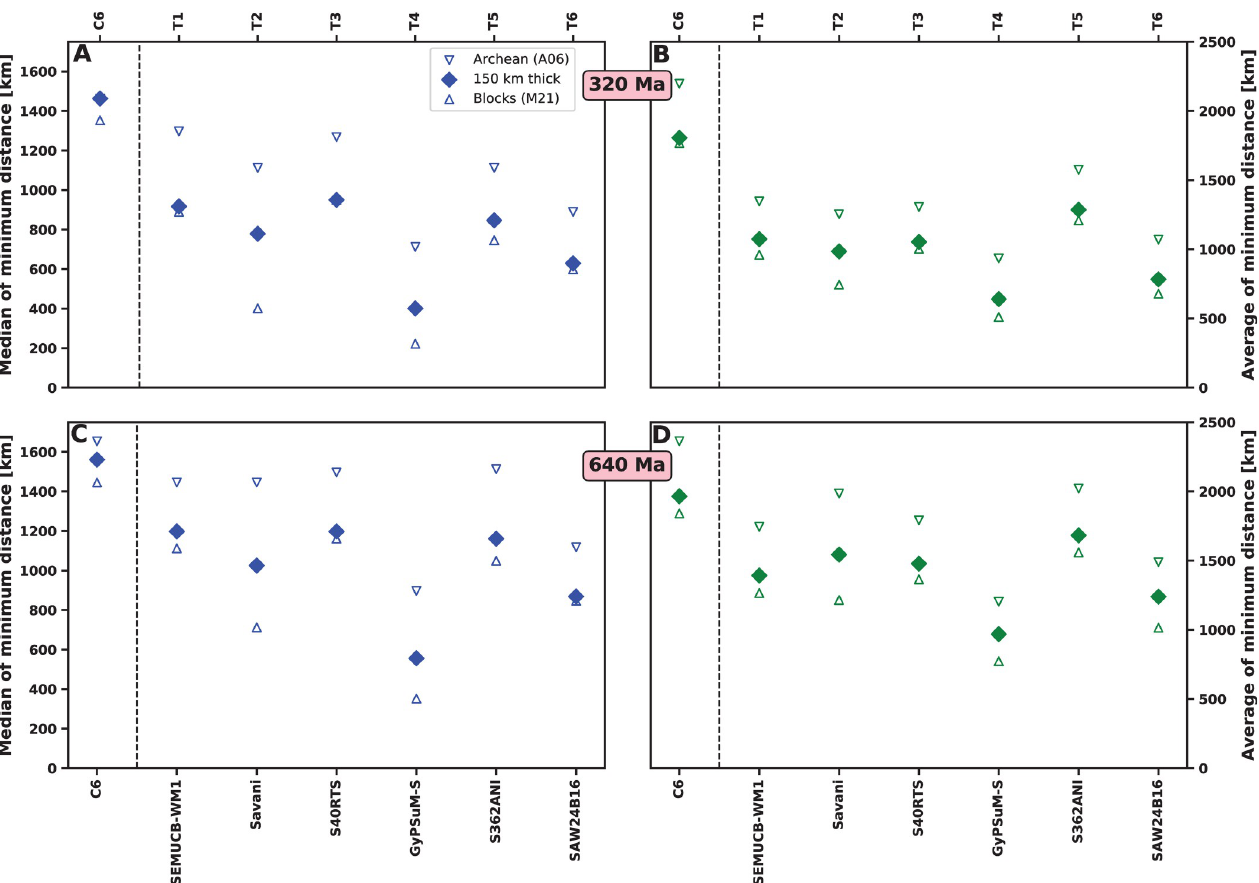
Fig 11. Results for lithosphere thicker than 150 km [5] and reconstruction M21NNR. Metrics from EDFs for lithosphere thicker than 150 km [5] and reconstruction M21NNR for mantle flow and tomographic models from 320 Ma ( A-B ) and from 640 Ma ( C-D ). A, C/ Median and B, D/ average minimum distances with one standard deviation as error bar. In each panel, mantle flow model cases are to the left and tomographic models to the right of the dashed vertical